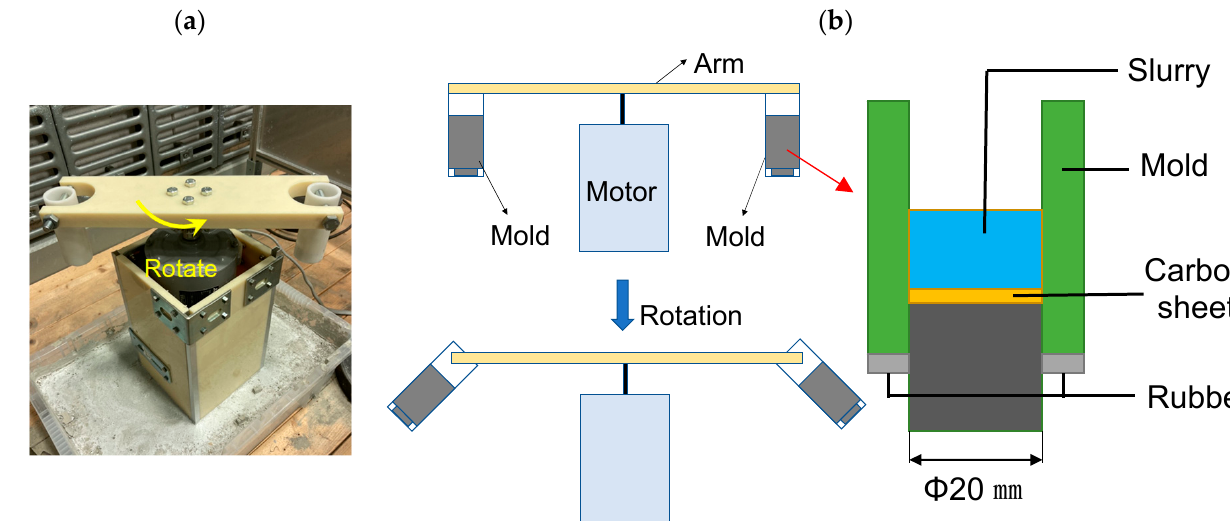
Figure 1. Centrifugal slurry equipment (( a ) apparatus photo and ( b ) schematic illustrations).